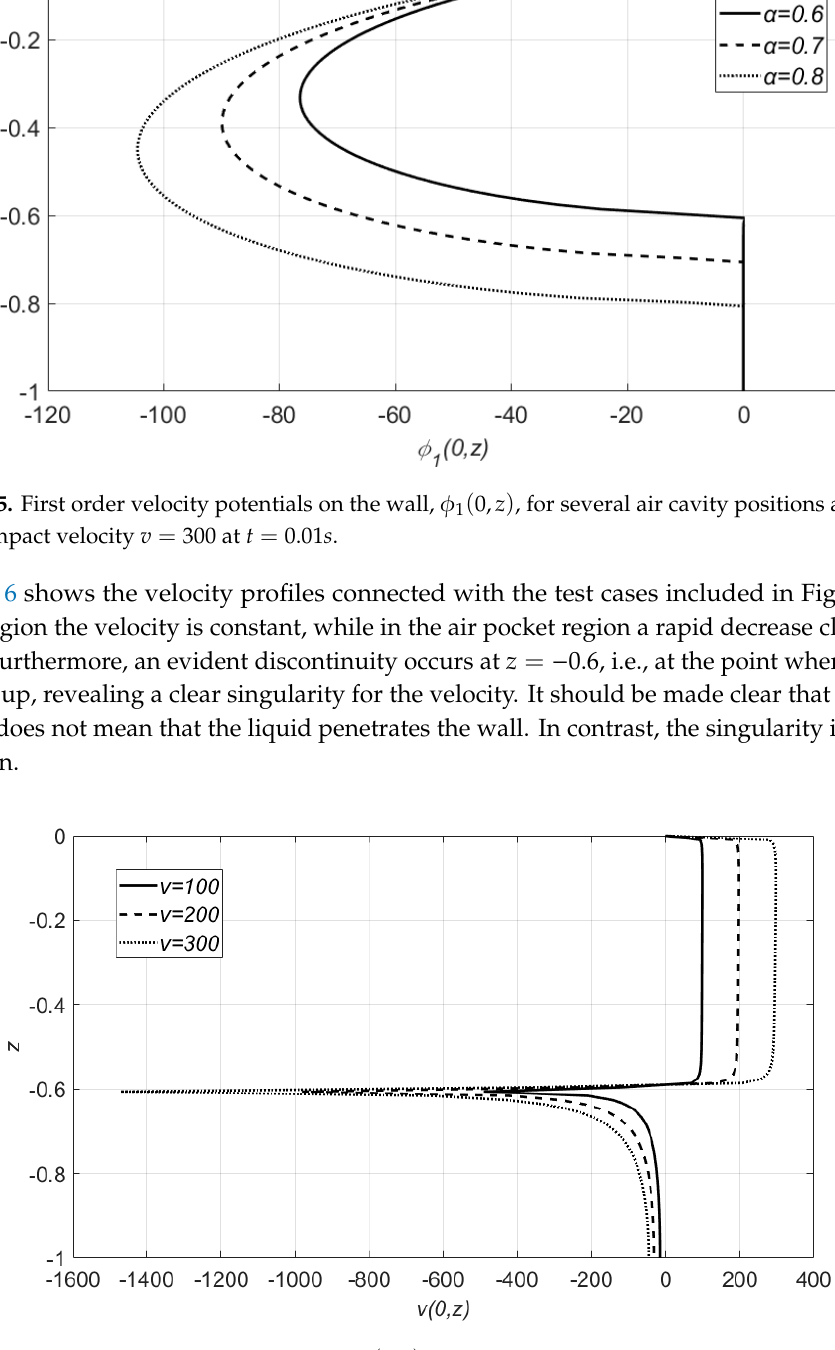
Figure 7. Hydrodynamic pressure distributions in the liquid field for (cid:1874) = 300 and fixed air cavity position −1 ≤ (cid:1878) (cid:3030)(cid:3028)(cid:3049)(cid:3036)(cid:3047)(cid:3052) ≤ −0.6 at (cid:1872) = 0.01(cid:1871) . The contours of the hydrodynamic pressure (that correspond to Figure 7) are shown in Figure 8. The isobaric lines testify that the highest pressures occur in the wave impact zone.